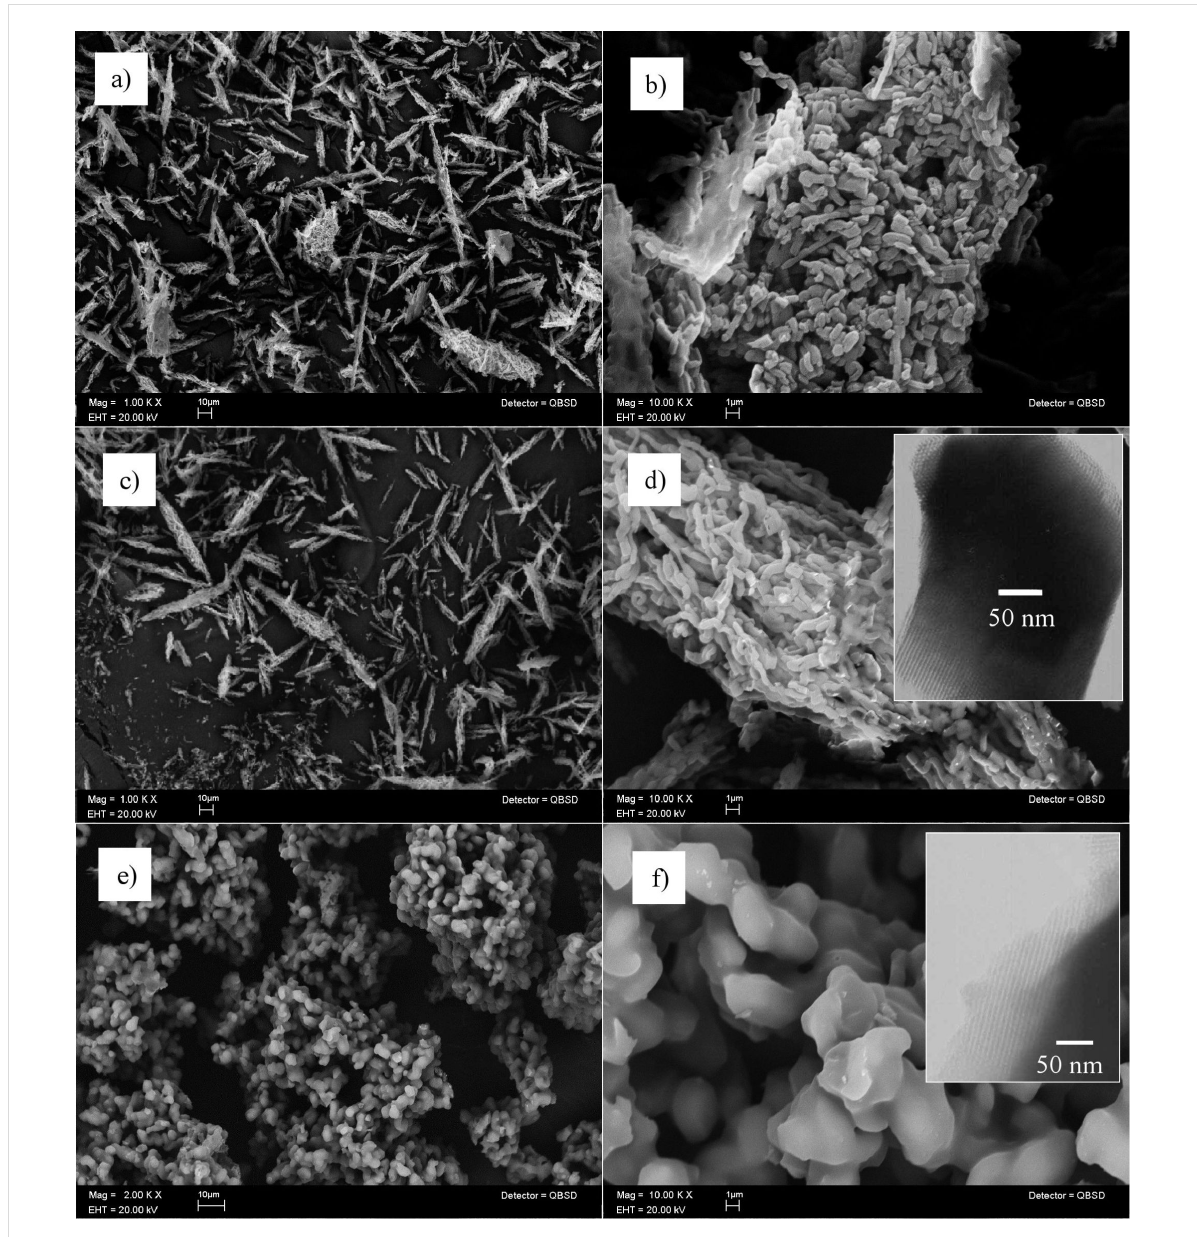
Figure 3: Composite SEM micrographs of a) and b) HT/SBA(C), c) and d) HT/SBA(NC), e) and f) in situ (Mg/Al)/SBA. Inset: TEM micrographs .